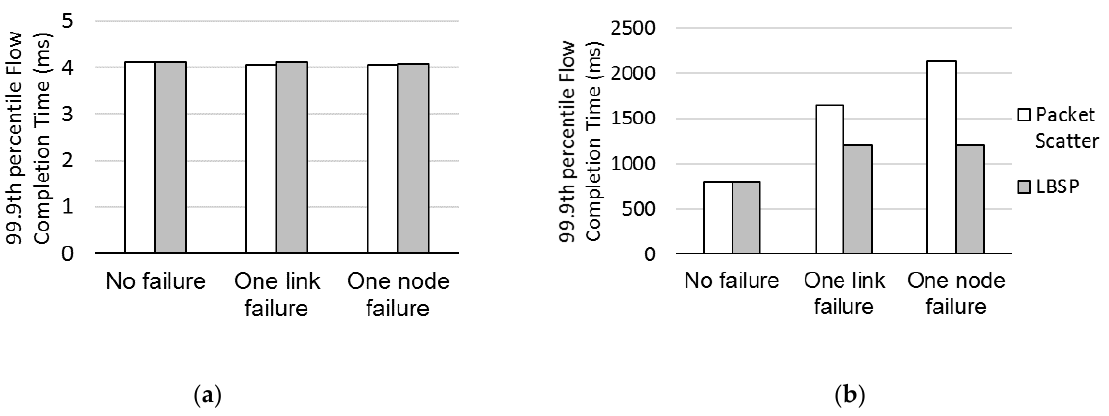
Figure 6. Flow completion time in tests for an 8-ary fat-tree: ( a ) result of all-in-all short-lived flow tests; and ( b ) result of long-lived flow tests.